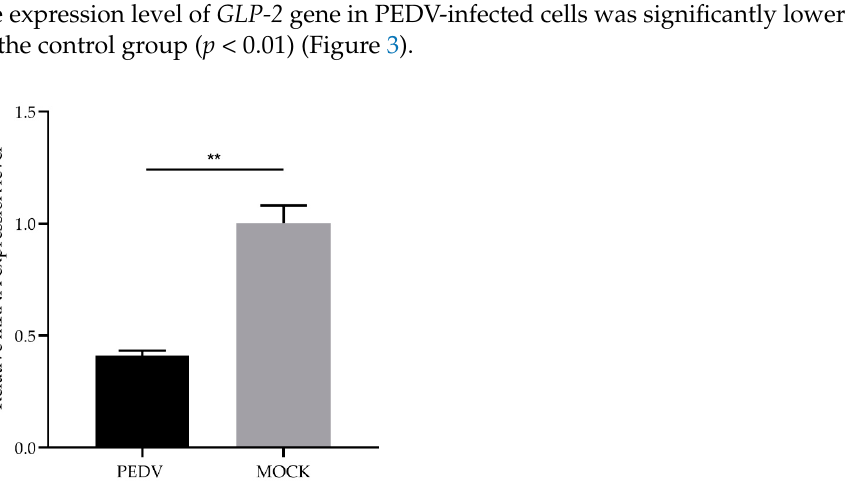
Figure 4. Verification of GLP-2 gene interference efficiency. ( A ) Transfection of GLP-2 gene shRNAs vector into IPEC-J2 cells. ( B ) GLP-2 gene mRNA expression level. shRNA NC represents negative control. shRNA1 shRNA2 and shRNA3 represent three RNA interference fragments of the GLP-2 gene. * p < 0.05, ** p < 0.01. Bars represent the mean ± SD ( n = 3). 3.6. Effect of GLP-2 Gene Silencing on PEDV Infection To further verify the effects of GLP-2 gene expression on PEDV infection, total RNA from shRNA1 and shRNA2 interfering cells infected by PEDV was extracted for M gene copy number detection. The results showed that the copy number of the PEDV M gene in the GLP-2 interfering cells was significantly higher than that in the control group ( p < 0.01)